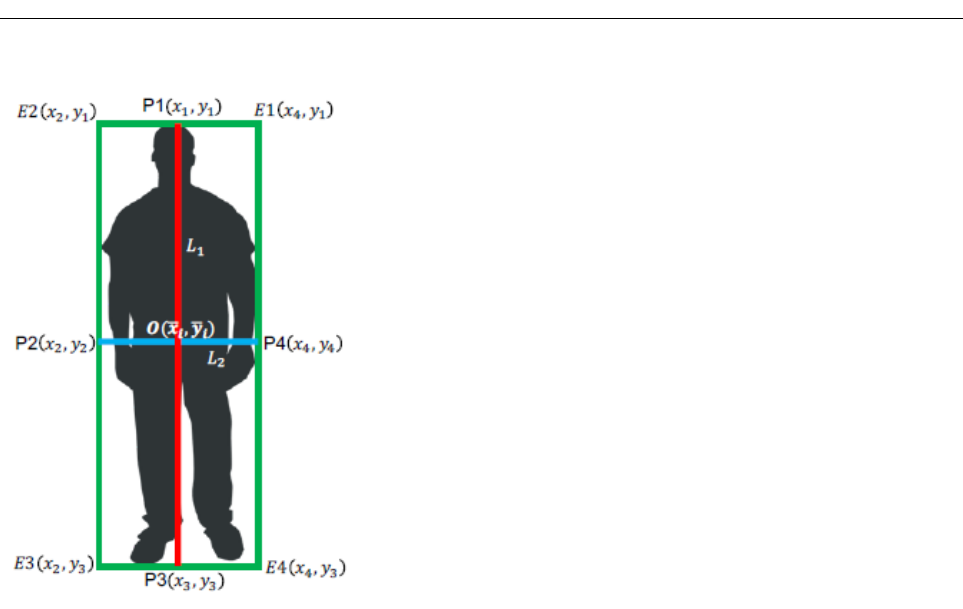
Figure 3. Movement region (green rectangle) bounded by the extreme points: E 1 ( x 4 , y 1 ) , E 2 ( x 2 , y 1 ) , E 3 ( x 2 , y 3 ) , and E 4 ( x 4 , y 3 ) , of the lines L 1 and L 2 , whose direction vectors are the eigenvectors [ (cid:126) v 1 , (cid:126) v 2 ] .